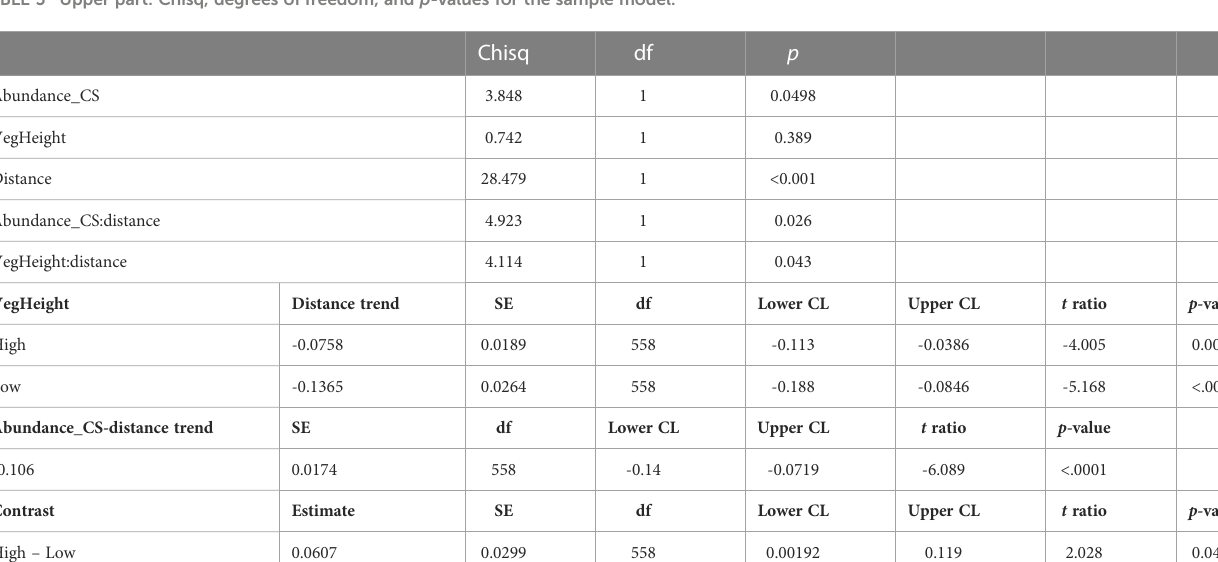
TABLE 5 Upper part: Chisq, degrees of freedom, and p ‐ values for the sample model.